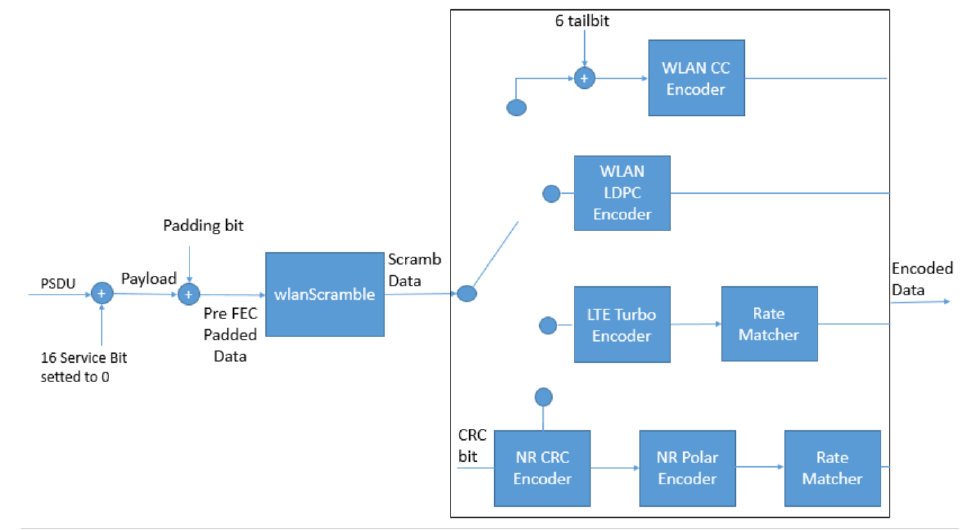
Figure 4. Modified block for studying the channel codes for IEEE